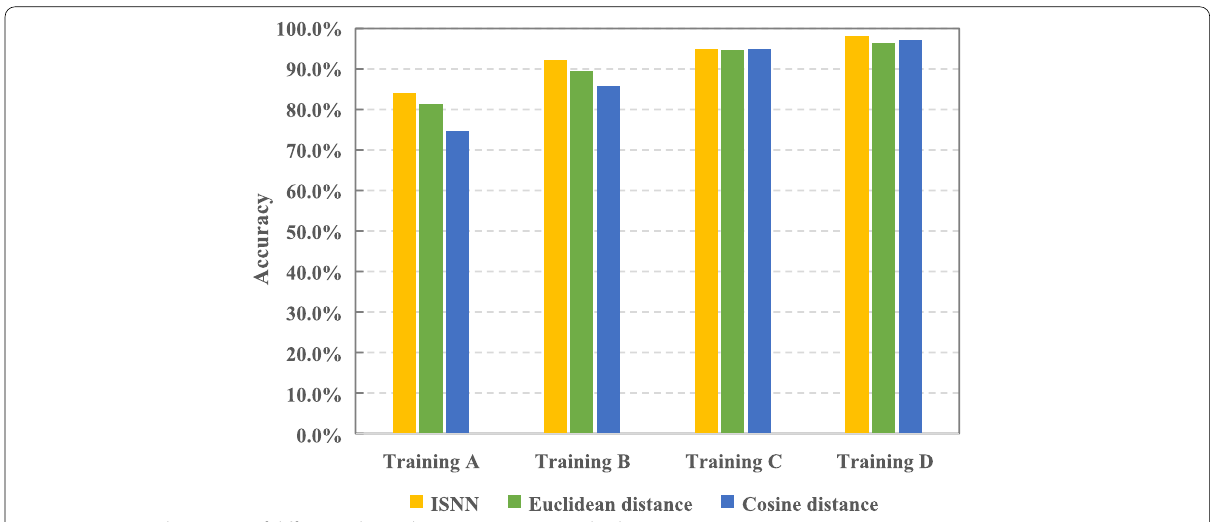
Fig. 11 Accuracy histogram of different relationship measurement methods